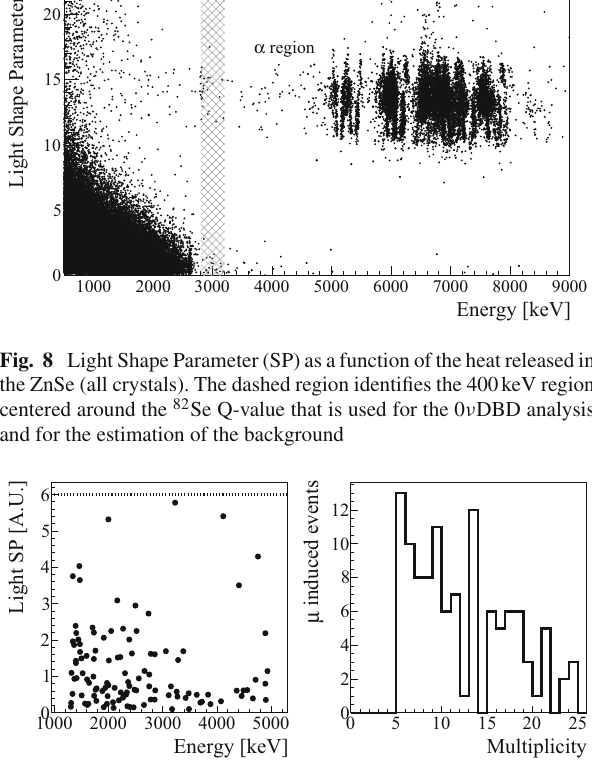
Fig. 9 Left: Light Shape Parameter distribution for muon-induced events as a function of the heat released in the ZnSe. The dotted black line represent the cut on SP. Right: histogram of the number of ZnSe crystals with a simultaneous trigger